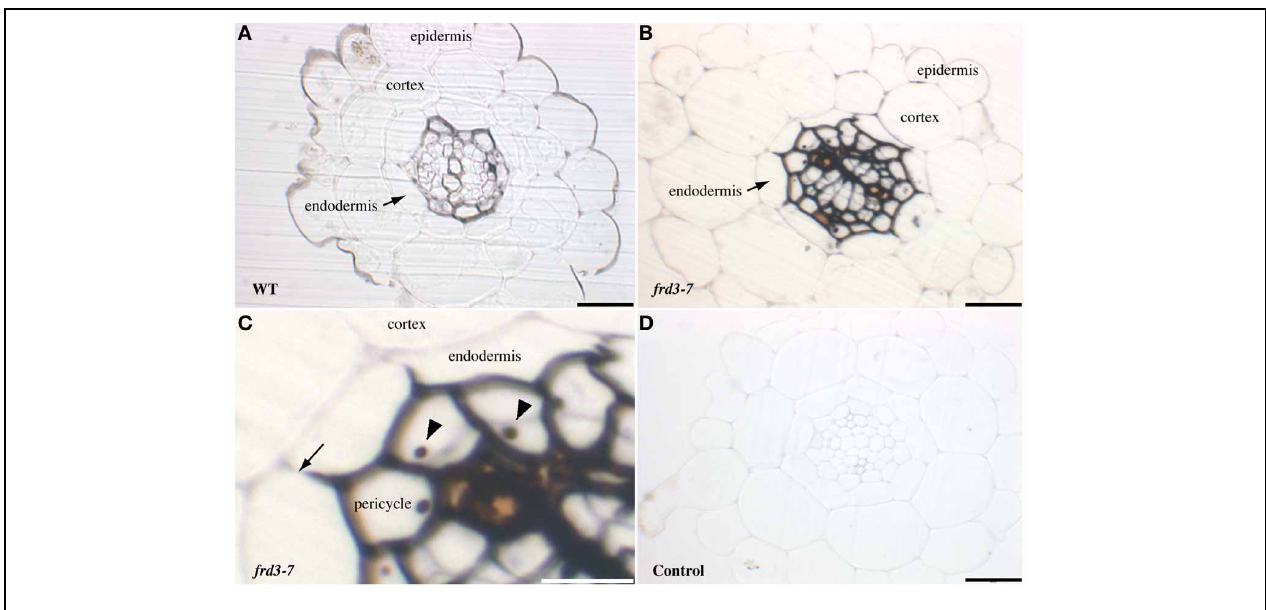
FIGURE 1 | Iron detection in Arabidopsis roots. Sections of 4-week old WT (A) or frd3-7 (B–D) mutant plants stained with Perls/DAB. Panel (C) corresponds to a magnified image of panel (B) , both showing iron